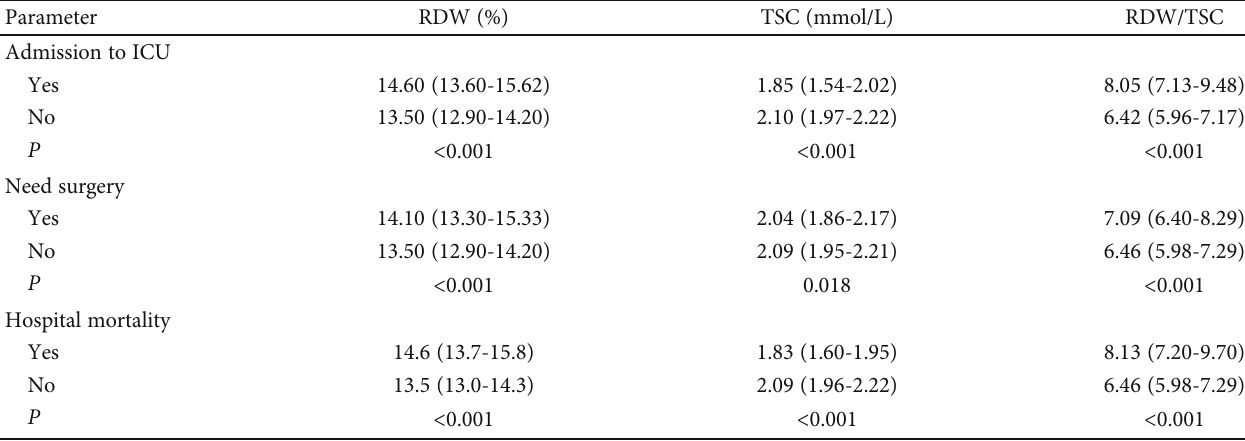
Table 2: The di ff erences of RDW, TSC, and RDW/TSC according to di ff erent